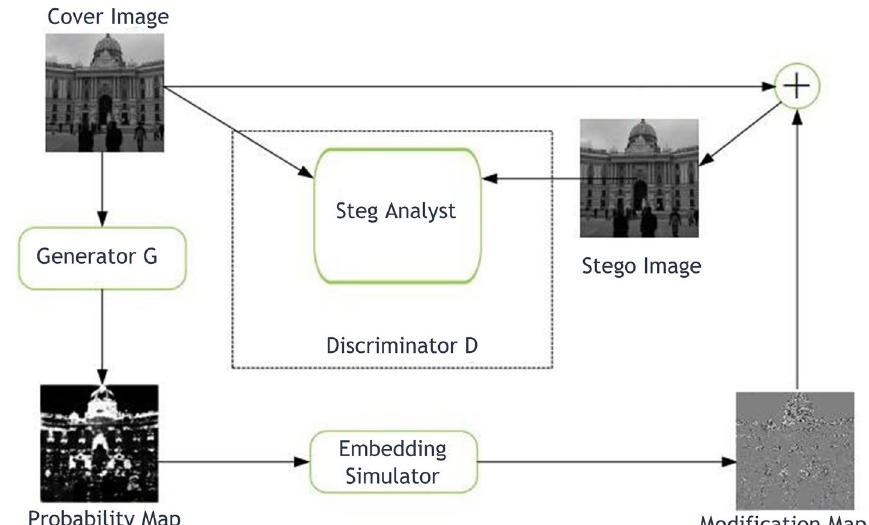
Fig. 2 The (Alteration Probability Map) looked at in [26] was made with the “Automatic Steganographic Distortion Learning”